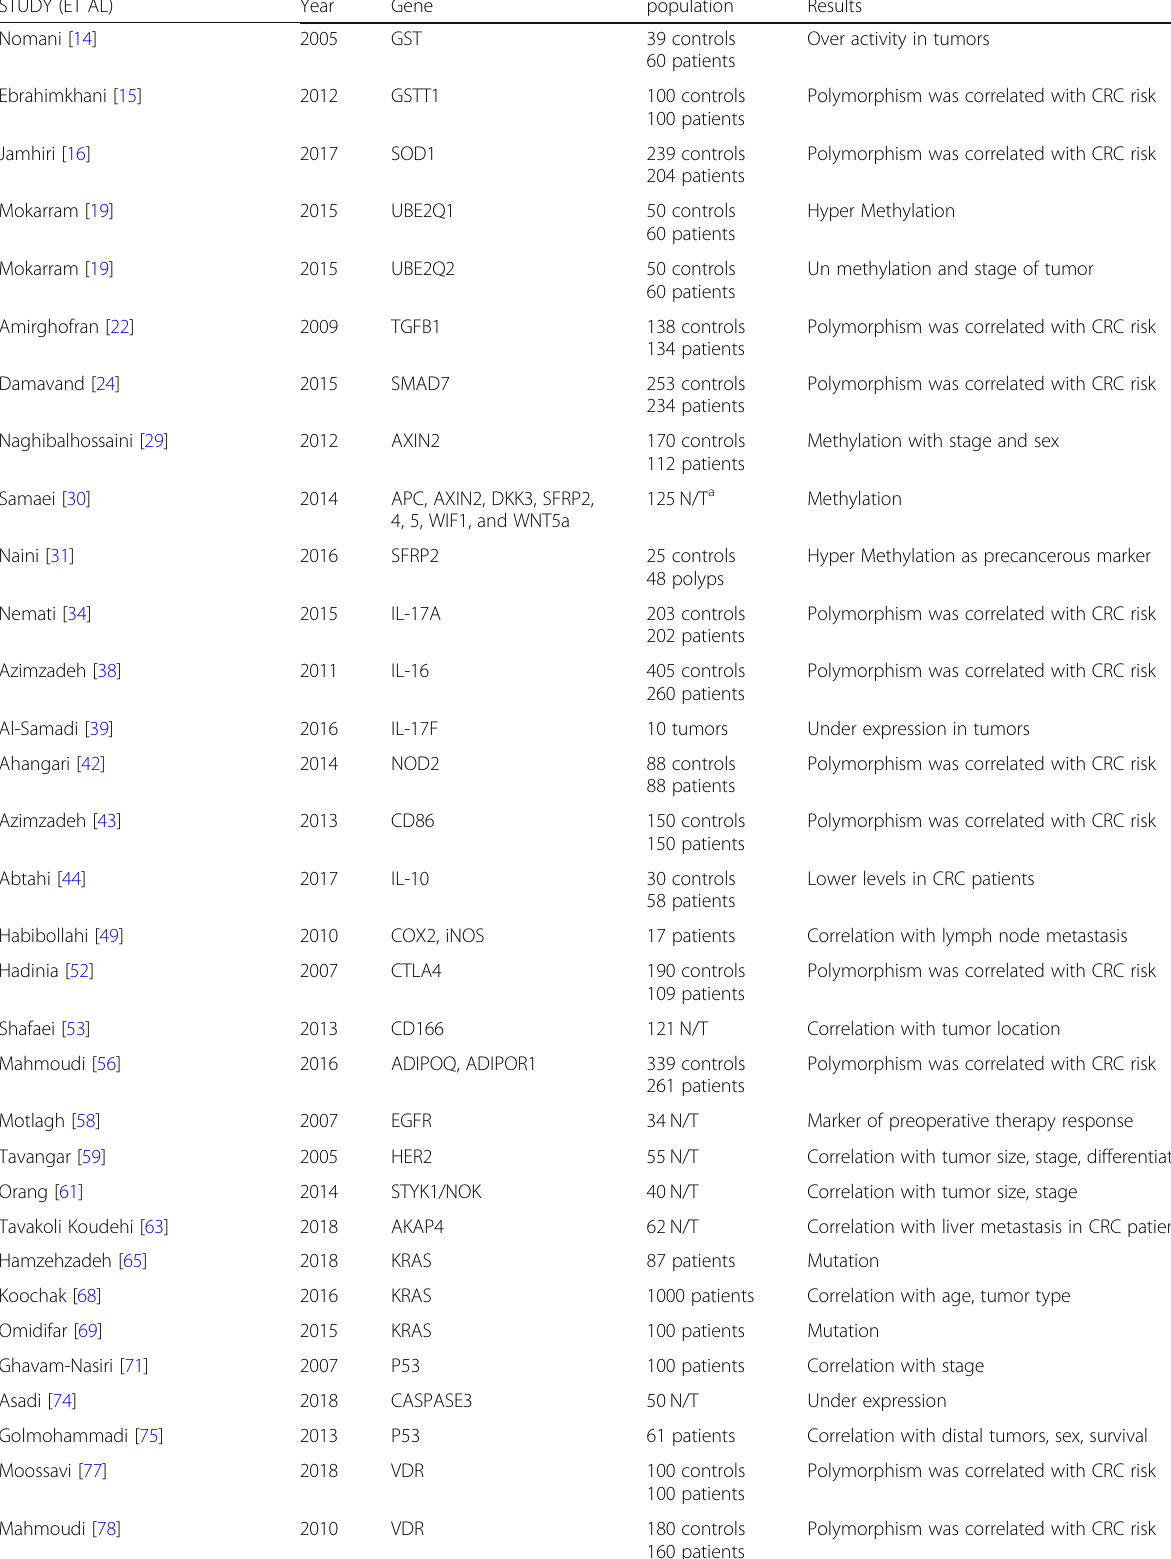
Table 1 All of the involved markers in CRC susceptibility among the Iranian patients STUDY (ET